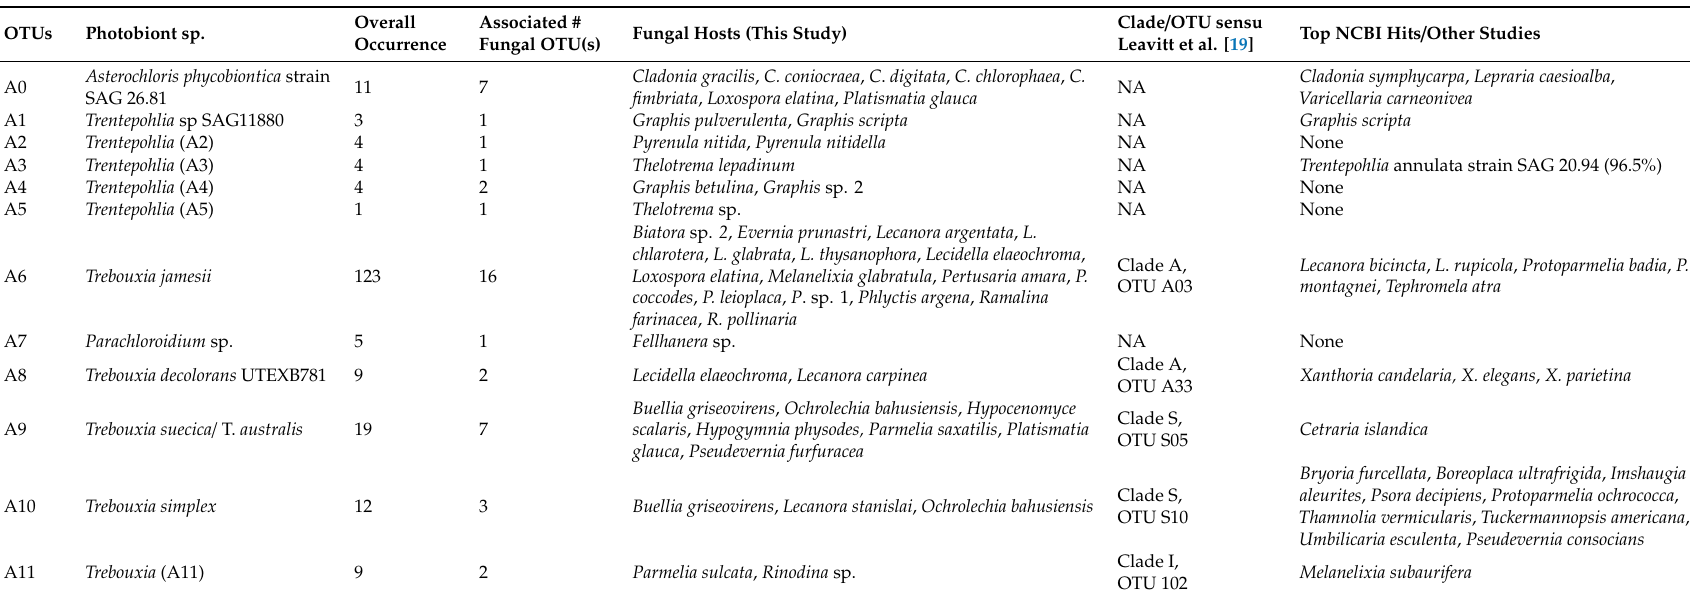
Table 3. Algal OTUs: Summary of the sampled photobiont sequences, including their frequency and fungal hosts. OTUs Photobiont